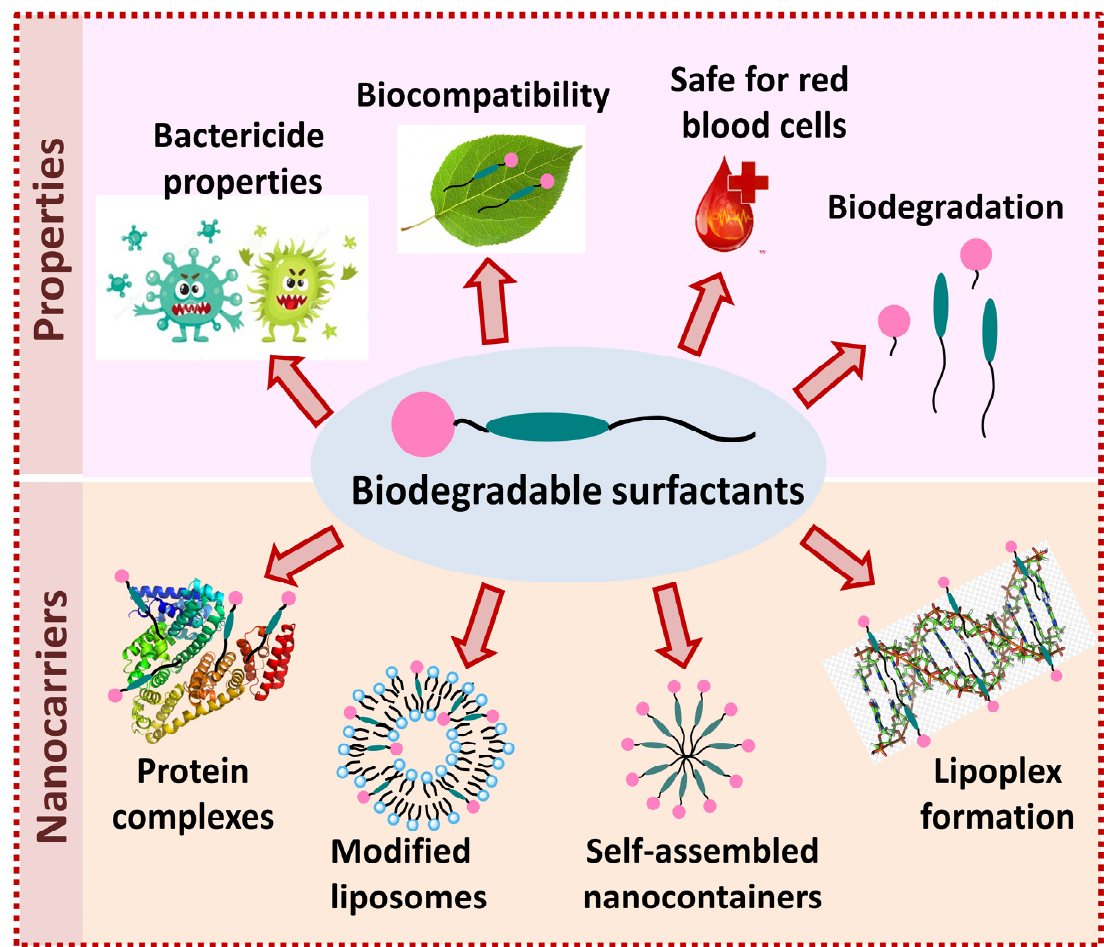
Figure 6. Properties of biodegradable surfactants and nanocarriers based on